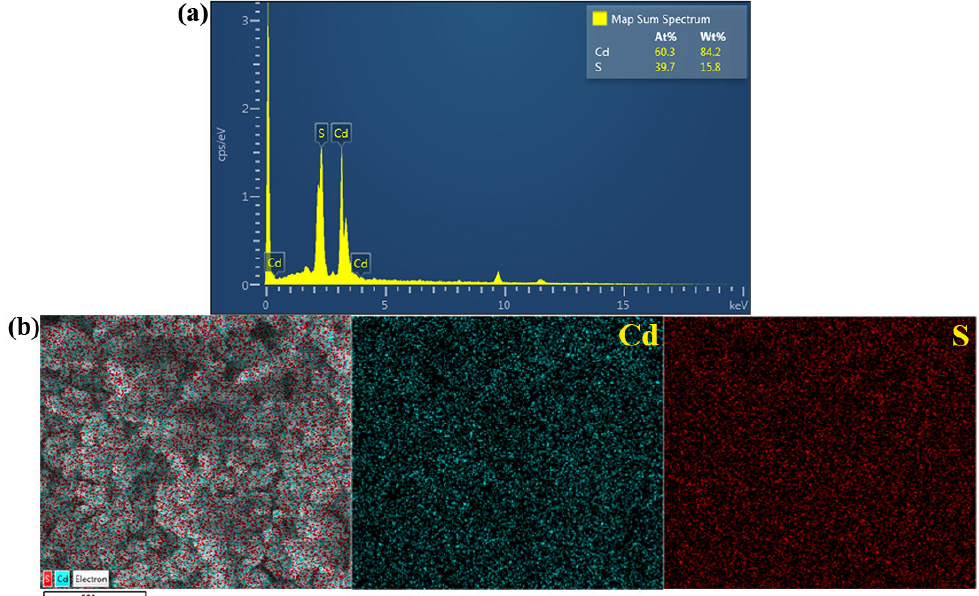
Figure 2. EDX spectrum ( a ), SEM image of the mapping area, and EDX elementary mapping of the Cd and S of CdS nanoparticles ( b ).